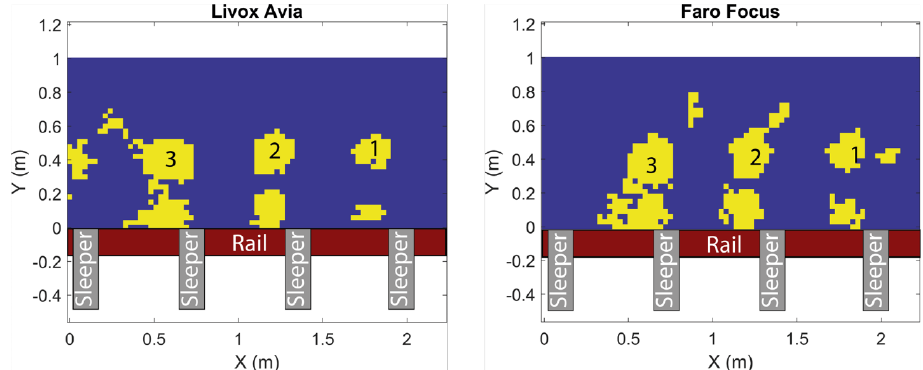
Figure 9. Binary images indicating the ballast displacements and holes: LiVOX Avia (left) and Faro Focus 3D (right).